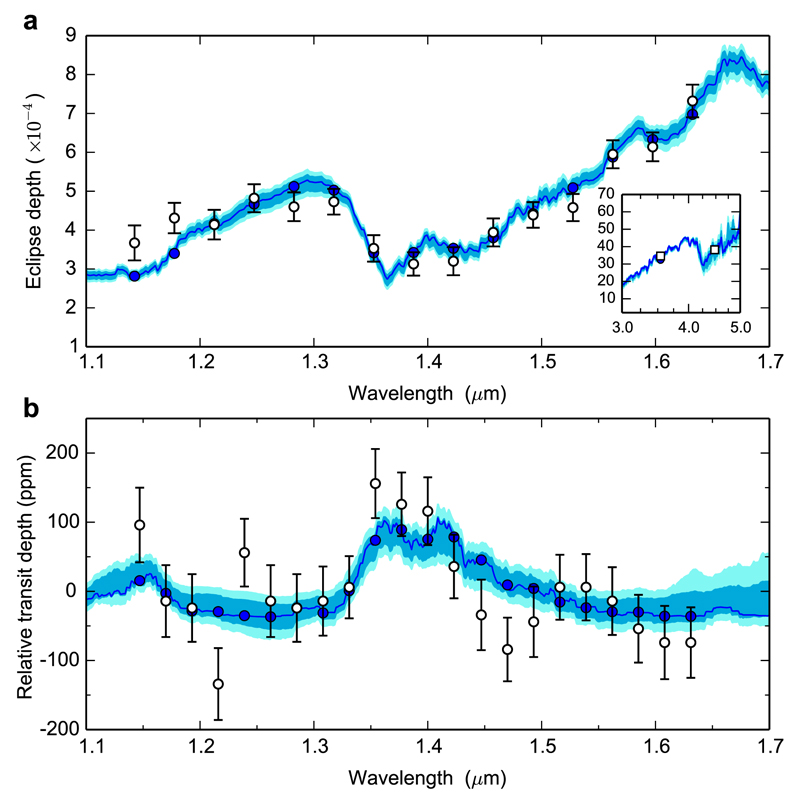
Spectra of the hot Jupiter WASP-43b observed with HST WFC3 (from Kreidberg et al. 2014b). Top: eclipse spectrum. Bottom: transmission spectrum. In both cases, the black circles with error bars show the data and solid curves show best-fit model spectra. The filled dark blue circles show the best-fit model binned to the same resolution as the data